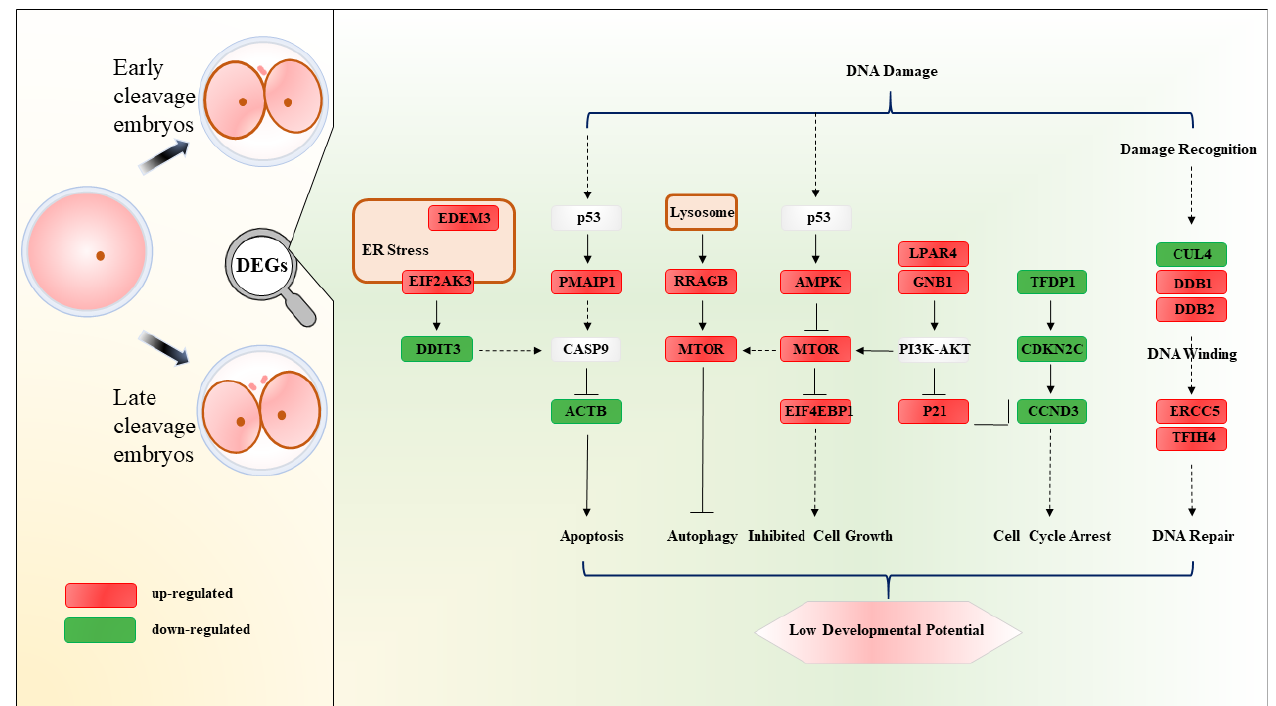
Figure 2. DEGs analysis between pig early cleavage embryos and late cleavage embryos of PA with one repeat per group. ( A ) The volcano plot shows the upregulation and downregulation of DEGs between early and late cleavage pig PA 2-cell embryos (|log 2 FC| ≥ 1, FDR < 0.05); The red dots represent upregulated genes, and the blue dots represent downregulated genes. ( B ) Heatmaps of DEGs in early and late cleavage pig PA 2-cell embryos. GO enrichment analysis of ( C ) upregulated and ( D ) downregulated DEGs. KEGG pathway enrichment analysis of ( E ) upregulated and ( F ) downregulated DEGs.